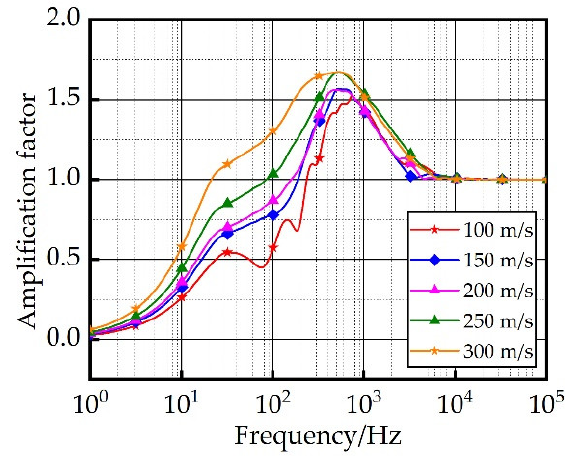
Figure 22. Acceleration shock response spectrum of vehicle with buffer at different speeds of water entry.